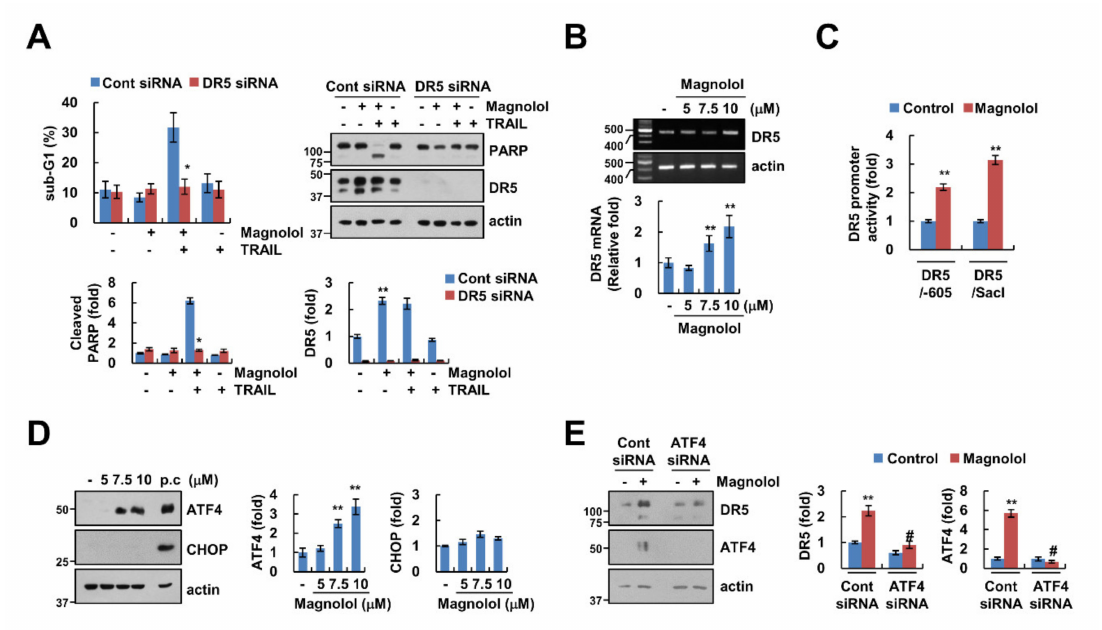
Figure 3. ATF4-dependent DR5 upregulation by magnolol was involved in TRAIL-induced apoptosis. ( A ) Caki-1 cells were transfected with control (Cont) or DR5 siRNA and were treated with 10 µ M magnolol alone, 50 ng / mL TRAIL alone or magnolol plus TRAIL for 24 h. ( B ) Caki-1 cells were treated with various concentrations of magnolol for 24 h. The levels of mRNA were examined using RT-PCR and quantitative PCR (qPCR). ( C ) Caki-1 cells were transiently transfected with DR5 (-605) or DR5 (SacI) promoter and incubated with 10 µ M magnolol for 24 h. The cells were lysed, and the luciferase activity was measured as described in Materials and Methods. ( D ) Caki-1 cells were treated with various concentrations of magnolol for 9 h. (positive control (p.c); 2 µ M brefeldin A). ( E ) Caki-1 cells were transfected with Cont or ATF4 siRNA and were treated with 10 µ M magnolol for 9 h. The sub-G1 population and protein expression were detected using flow cytometry ( A ) and Western blotting ( A , D , E ), respectively. The values in graph ( A – E ) represent the mean ± SD of three independent experiments. * p < 0.01 compared to the combined treatment with magnolol and TRAIL in control siRNA. ** p < 0.01 compared to control. # p < 0.01 compared to magnolol in control